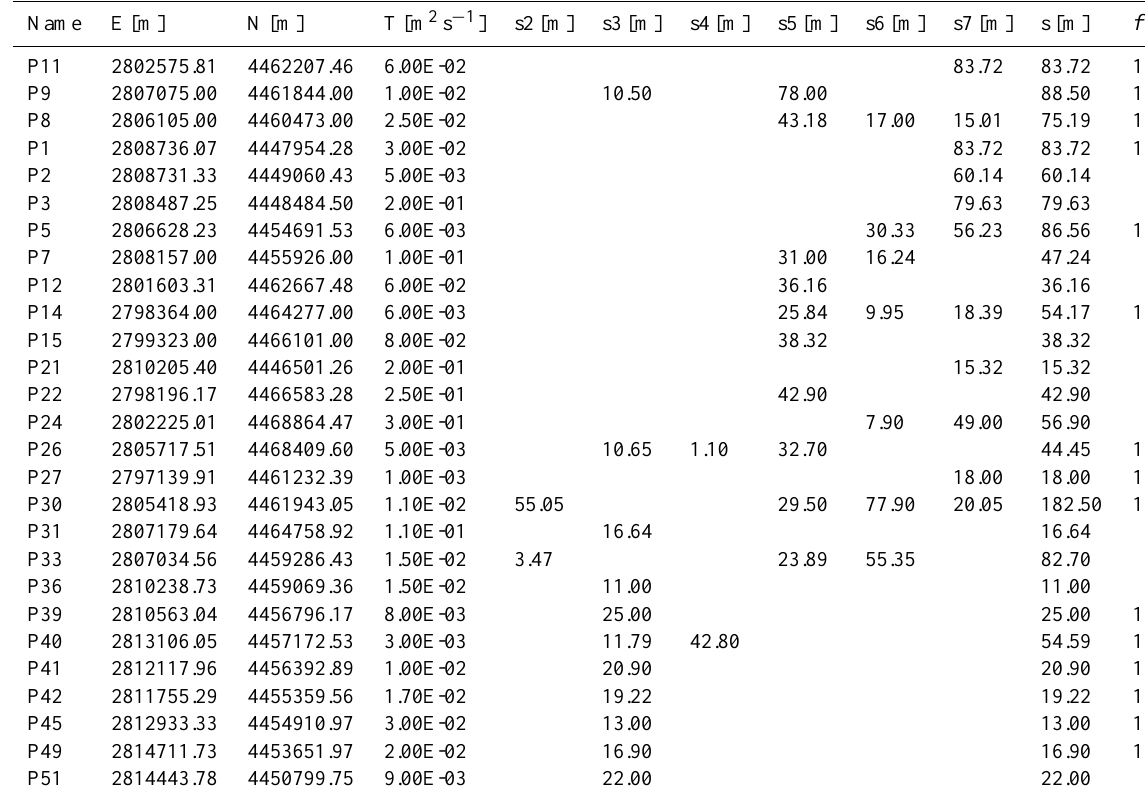
Table 1. Transmissivity and thickness of each lithotype in filtering zone for 27 wells. Where f =1 the well intercepts the fault.